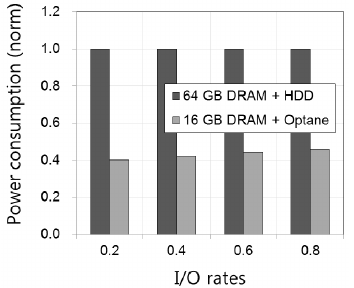
Figure 13. Comparison of power consumption .